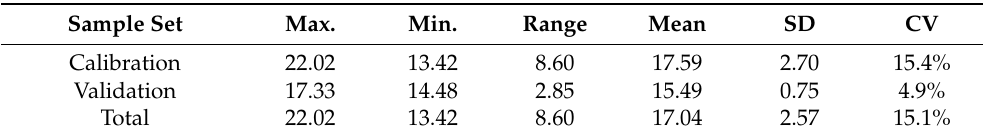
Table 1. Descriptive statistics of SOM